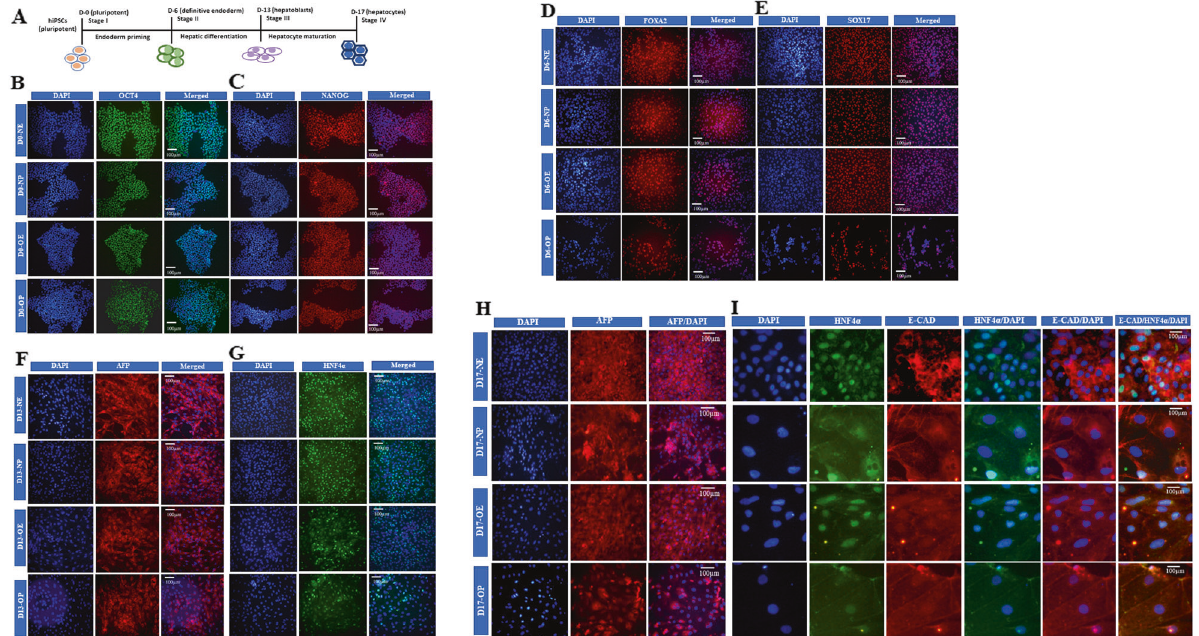
Fig. 1 In vitro hepatic differentiation of normal and obese iPSCs in control and treated with palmitate. A Schematic representation of stage-speci fi c differentiation of normal and obese iPSCs into hepatocytes. Immunostaining images showing the expression of stage-speci fi c markers in ethanol and palmitate treated control and obese iPSCs-derived cells at various stages of differentiation. Pluripotency markers B OCT4 and C NANOG expression on day 0 of differentiation. De fi nitive endoderm markers D FOXA2 and E SOX17 were expressed on day 6 of differentiation. Hepatoblast markers F AFP-1 and G HNF4 α expression on day 13 of differentiation. Expression of H AFP-1 I HNAF4 α and E-CAD (E-Cadherin) in hepatocytes on day 17 of differentiation. Images were captured using the ×40 objective of Olympus IX70 Inverted Fluorescence Microscope. Scale bar = 100 µM. NE Normal iPSC-derived, ethanol-treated, NP- Normal iPSC-derived, palmitate treated, OE Obese iPSC-derived, ethanol-treated; OP Obese iPSC-derived, palmitate